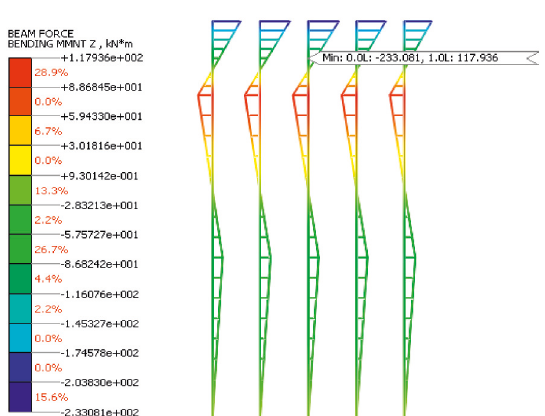
Figure 14: Cloud diagram of bending moment distribution of typical pile foundation.